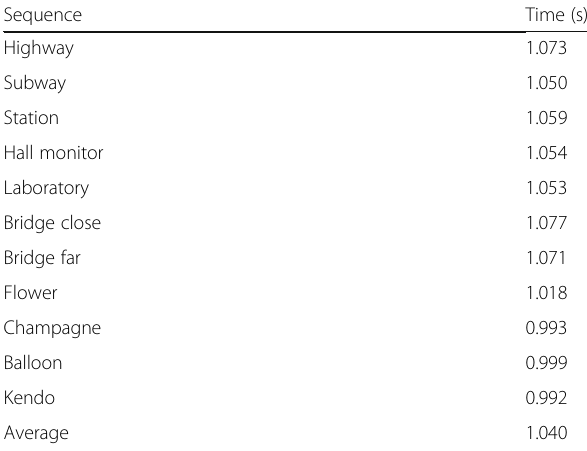
Table 2 Execution time for each sequence (on PC environment) Sequence